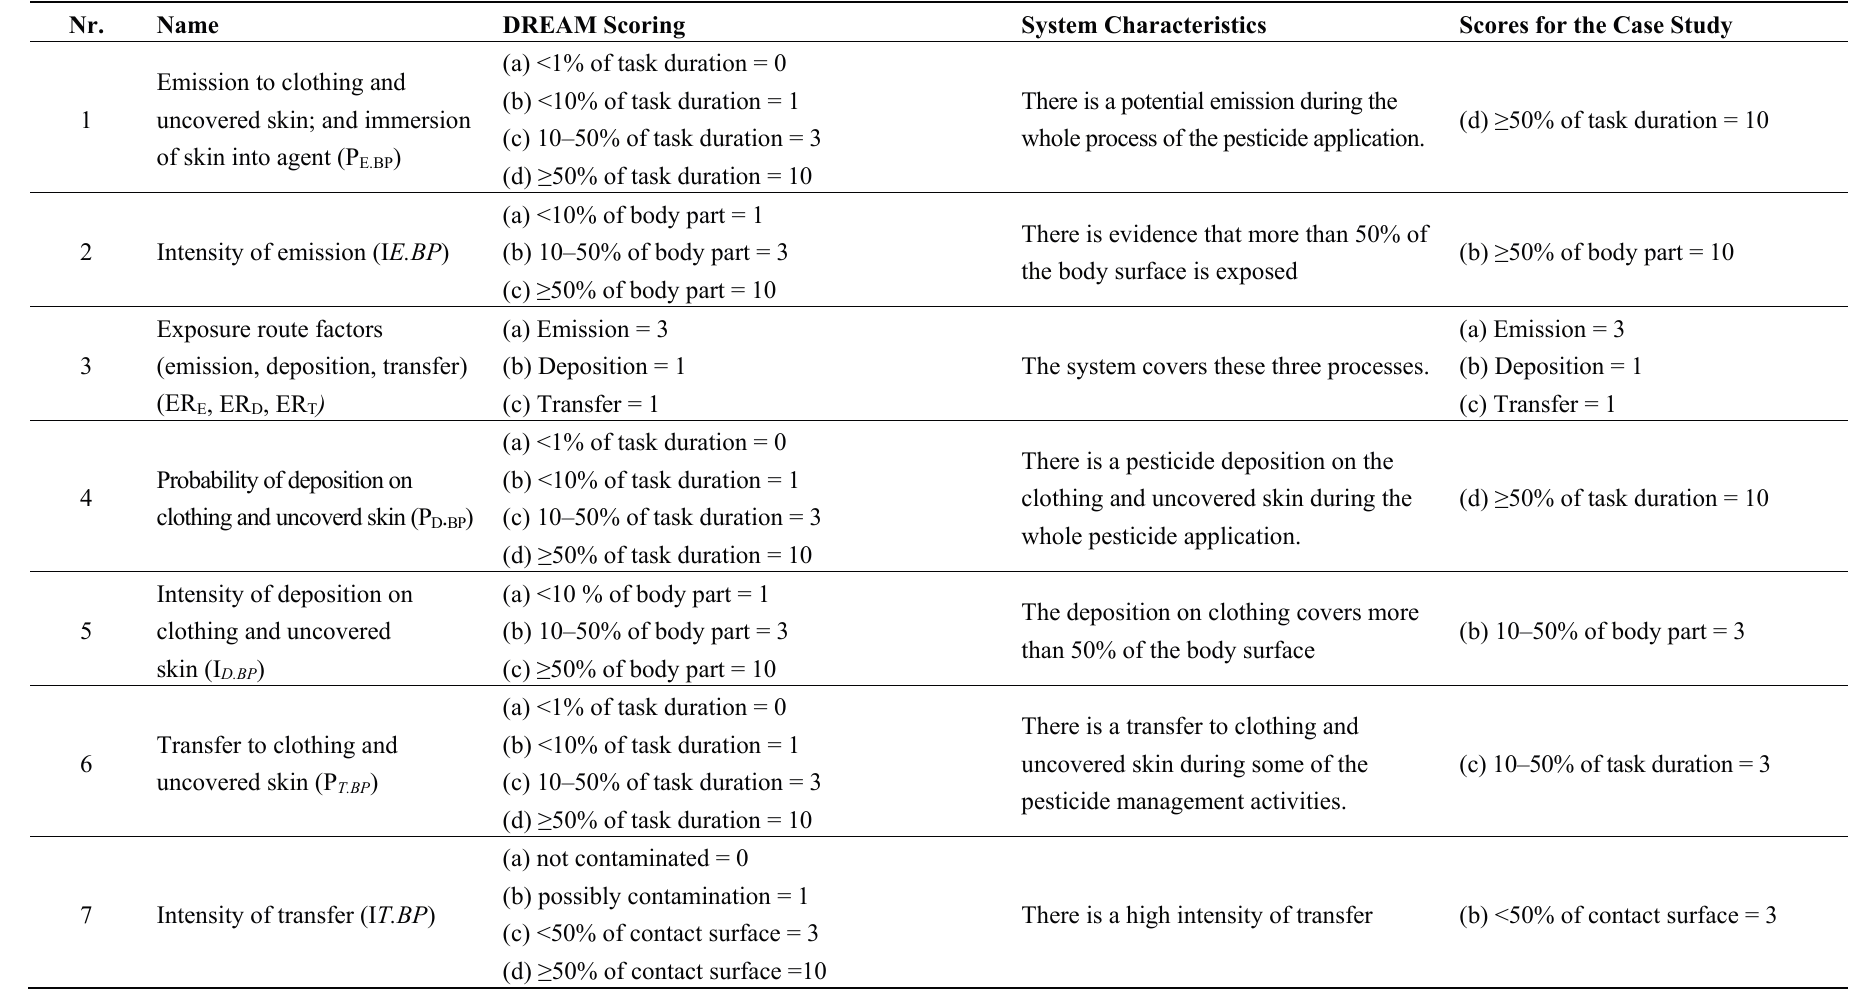
Table A2. DREAM Scoring System for the Case